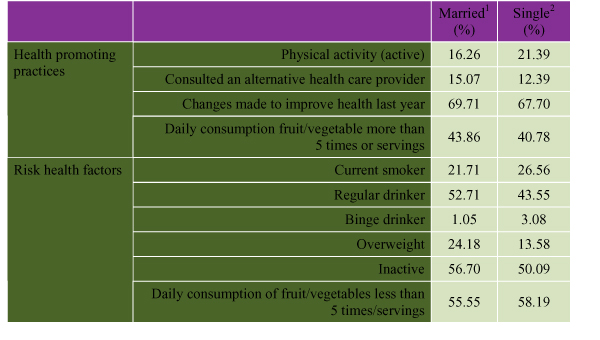
Marital Status and Health Practices (not age-adjusted). Source: Statistics Canada, CCHS, 2000–2001.1 Married status includes married and common-law.  2 Single status includes widowed, separated and divorced.